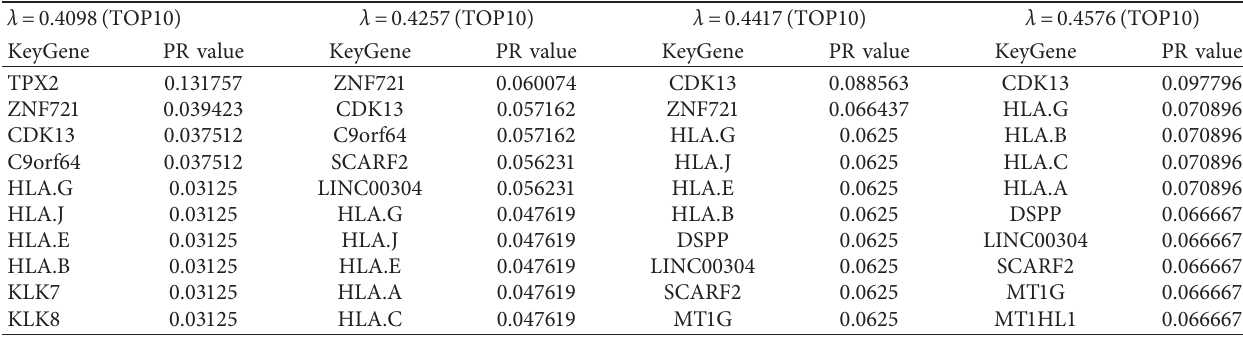
Table 4: TOP gene and PR values with different thresholds under the PageRank algorithm.